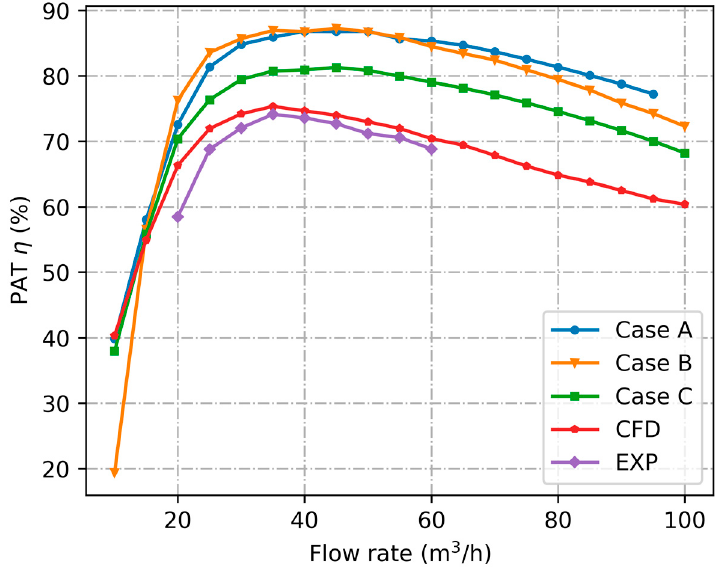
Figure 11. Comparison of PAT efficiencies for different case scenarios. Table 4. Improvement of optimized cases with respect to the baseline model.